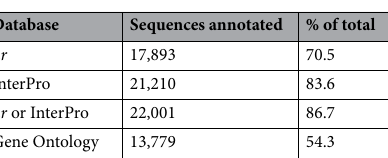
Table 3. Functional annotation of 25,382 predicted proteins in the RPW pseudo-haplotype1